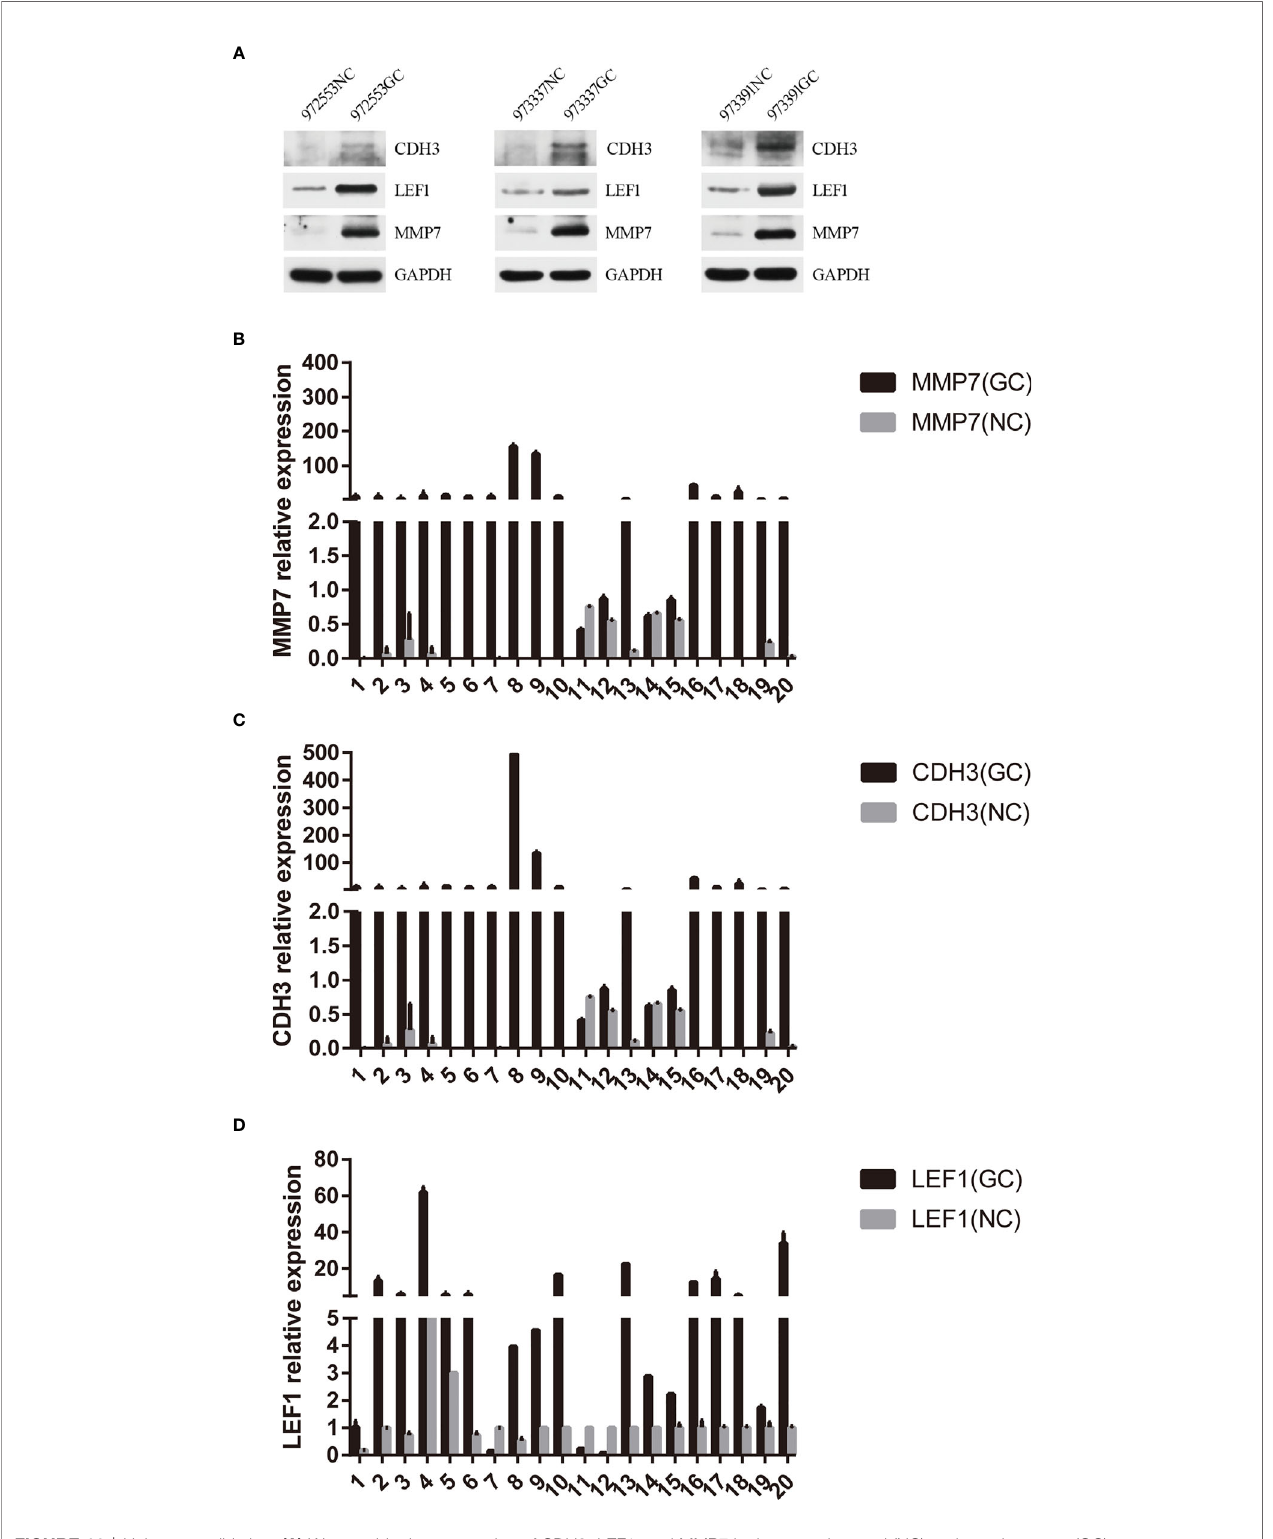
FIGURE 11 | Hub gene validation. (A) Western blotting expression of CDH3, LEF1, and MMP7 in the normal control (NC) and gastric cancer (GC) groups. (B) Relative expression of MMP7 by RT-qPCR analysis. P<0.05, compared with control. (C) Relative expression of CDH3 by RT-qPCR analysis. P<0.05, compared with control. (D) Relative expression of LEF1 by RT-qPCR analysis. P<0.05, compared with